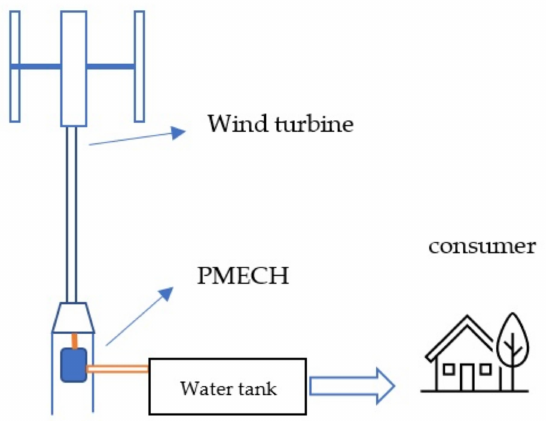
Figure 2. Diagram of the wind-heat